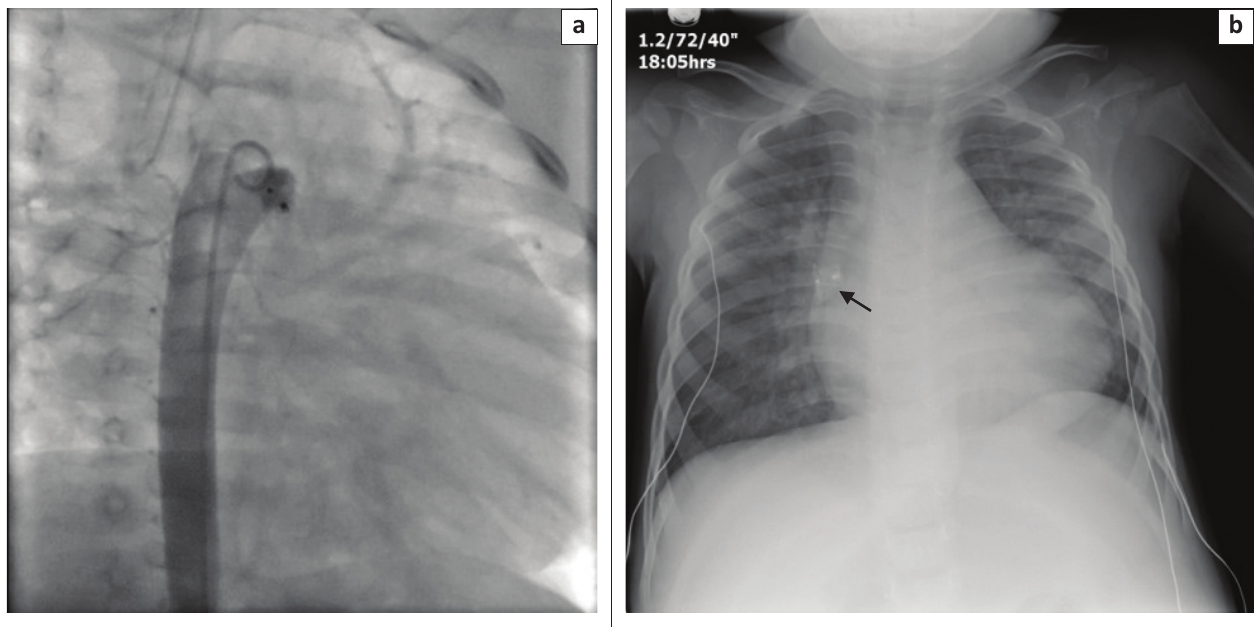
FIGURE 22: A migrated amplatzer duct occluder placed for patent ductus arteriosus. Aortogram in the oblique anterior–posterior view (a) shows transcatheter deployment of the amplatzer duct occluder in the lumen of the aorta. Post-procedural chest radiograph (b) shows migration of the device